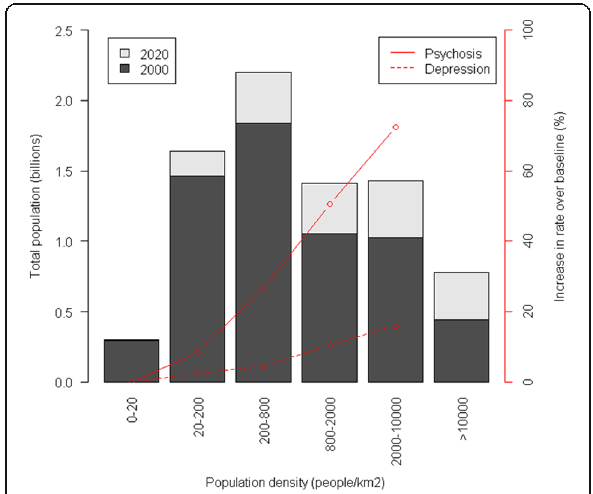
Fig. 4 Population density and the urban psychological penalty. The bar chart shows the total global population living in different population density classes, calculated from the Gridded Population of the World for 2000 and 2020. The red lines show the increase in the hazard rate over baseline for two common mental illnesses, taken from Sundquist et al. [53], who studied 4.4 million people aged 25 – 64 in Sweden. Shown is the average increase in hazard rates across men and women. Note that Sweden does not have many neighborhoods with population densities above 10,000 people/km 2 , so the Sundquist et al. results are not